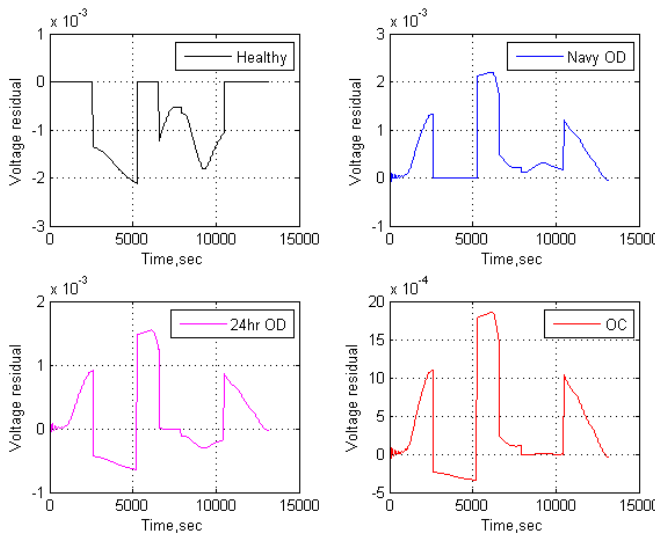
Figure 9. Calculated voltage residuals of respective battery models.